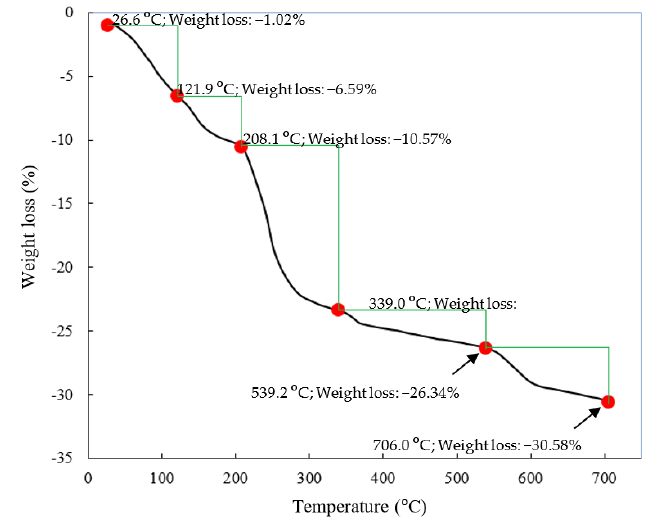
Figure 4. TGA curve of the synthesized ZHS nanoplates. The nitrogen adsorption–desorption isotherm, along with the BJH plot of the ZHS nanoplates, are given in Figure 5a,b, respectively. The main parameters are specific surface area (a s,BET ), mean pore diameter (r p ), and the most probable pore size (r p, peak (area)), and these equal to about 8.72 m 2 g − 1 , 2.3 nm, and 1.9 nm, respectively. Based on the obtained data, the synthesized nanoplates can be classified as mesoporous compounds.